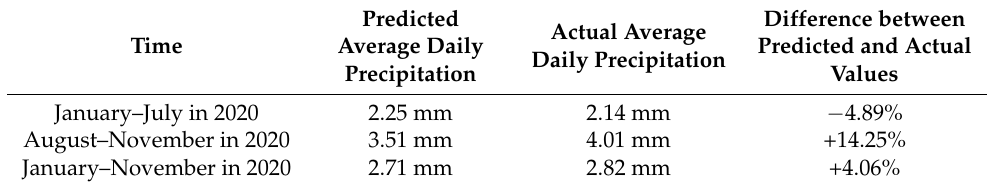
Table 7. Comparison of predicted and actual daily precipitation for